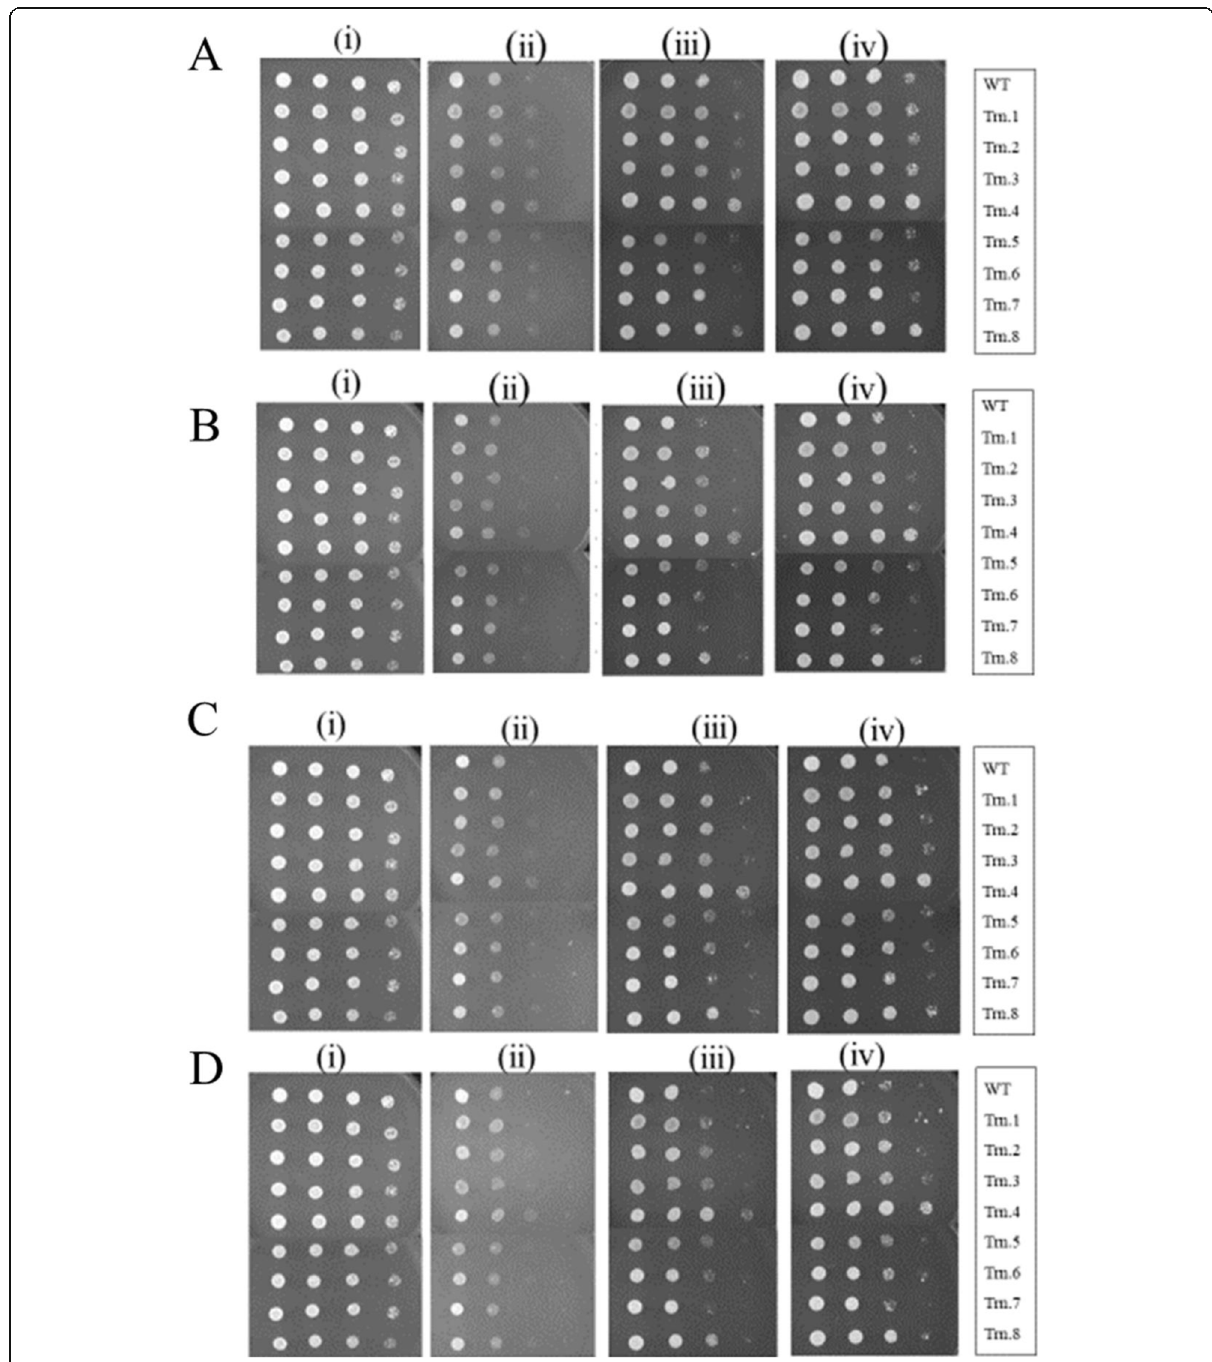
Fig. 7 Spot assay against fluconazole for the strains carrying truncated Chr4. WT, wild type strain CAF4-2; Trn.1 to Trn.8, Candida strains carrying truncations 1 – 8. Strains were 10-fold serially diluted (starting with 10 7 /ml) and spotted on plate containing fluconazole A 8 μ g/ml, B 16 μ g/ml, C 32 μ g/ml, and D 64 μ g/ml where (i) control plate without fluconazole and photograph was taken after 24 h. For a plate containing fluconazole, we took photographs at 24 h (ii), 48 h (iii), and 72 h (iv) after